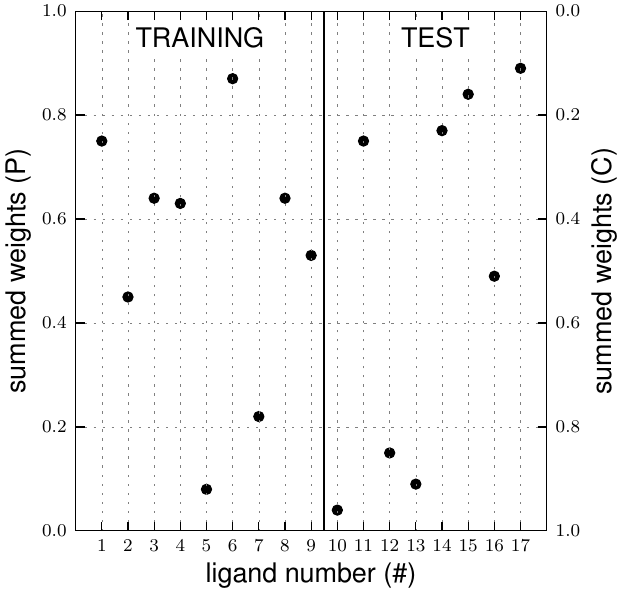
Figure 5. Summed Boltzmann weights of the simulations starting from either PPD70 (P) or CHZ170 (C) template structures for the aryloxypropanolamines (numbered 1–9 for the training set, 10–17 for the test set) within the final CYP 2D6 LIE model, which includes results of simulations starting from both the PPD70 and CHZ170 template